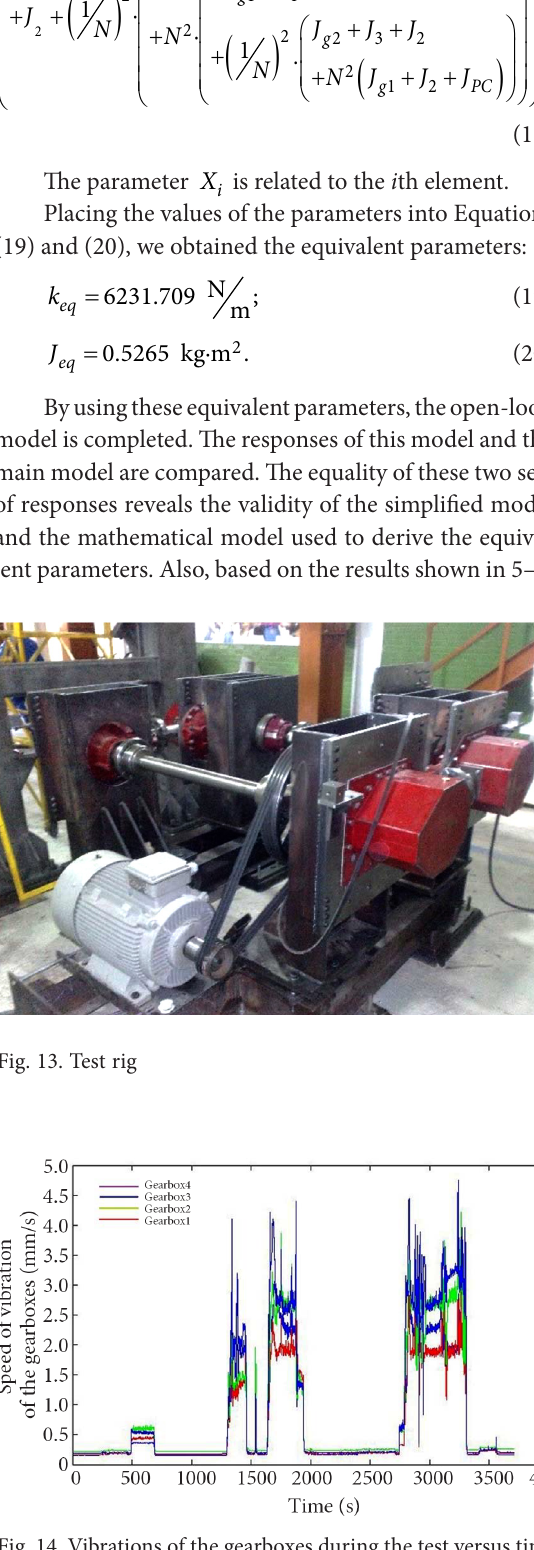
Fig. 14. Vibrations of the gearboxes during the test versus